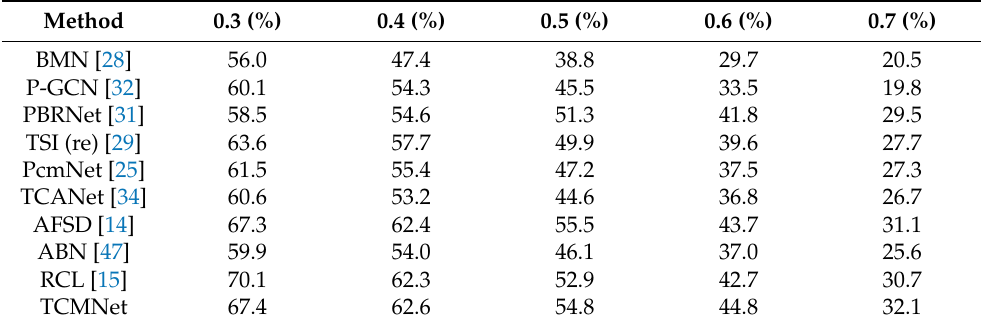
Table 7. Temporal action detection results on the test set of THUMOS14 in terms of mAP at different tIoU thresholds. “re” denotes that this method is re-implemented by